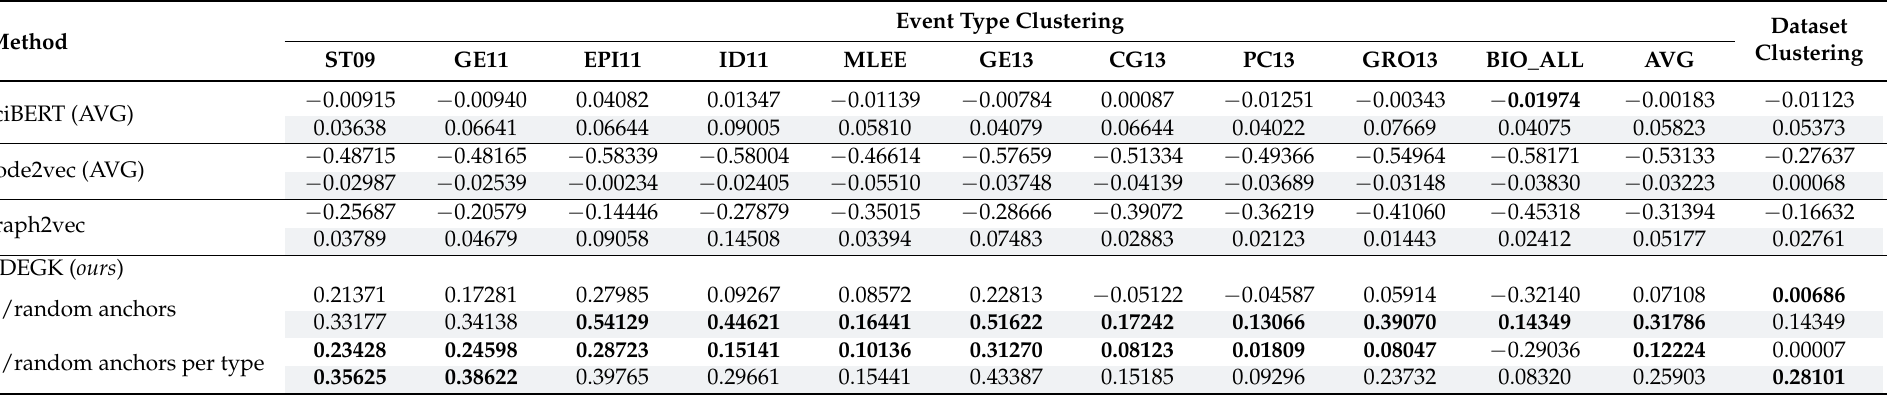
Table 4. Between-graph clustering results according to the silhouette score (white row) and range index (gray row). The best results for each dataset are shown in